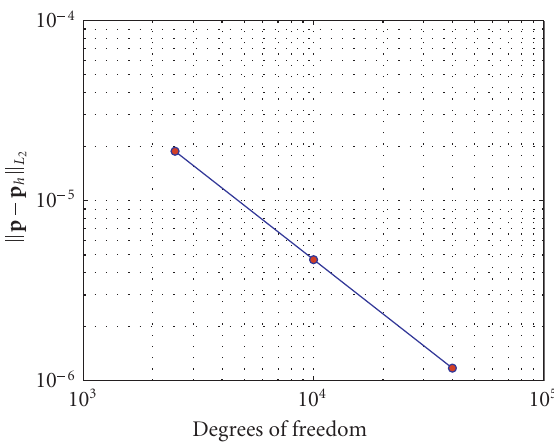
Figure 4.4 . Example 4.1: convergence of the discretization scheme. L 2 error versus the degrees of freedom in the mesh. We are observing (cid:4) p − p h (cid:4) L edge in the